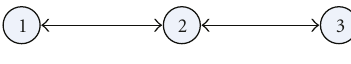
Figure 1: A three-node linear